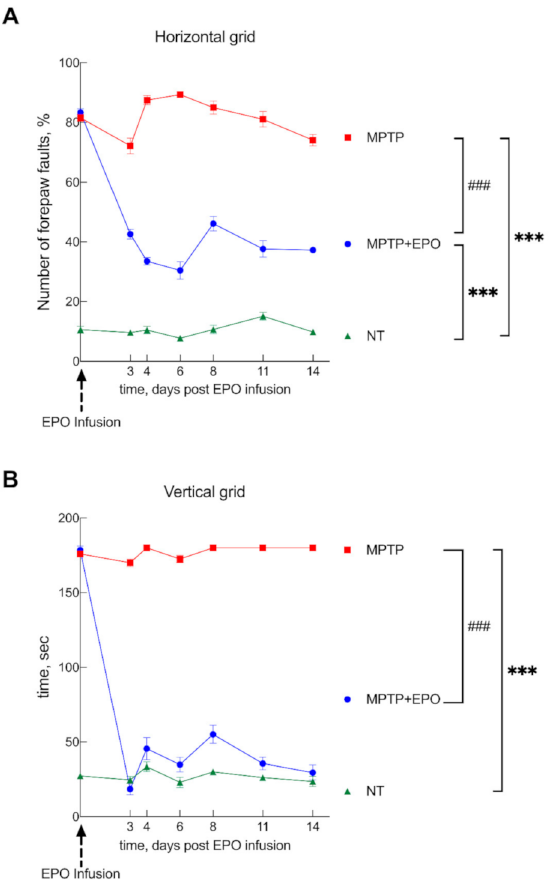
Figure 7. EPO promotes functional recovery in Parkinson’s disease (PD) mice. Mice were divided into three groups: healthy control, non-treated mice (NT), mice treated with MPTP to induce parkinsonism (MPTP), and mice treated with MPTP that received EPO 10 days after the induction of degeneration (day 0 see dashed arrow; MPTP + EPO). Animal behavior was monitored for 14 days after EPO administration and verified by two behavioral tests: the horizontal ( A ) and the vertical ( B ) grid test. Non-treated mice (green) are compared with MPTP (red) and MPTP+EPO (blue). Data are expressed as mean ± SEM ( n = 6 each group). *** p < 0.001 vs. NT; ### p < 0.001 vs.